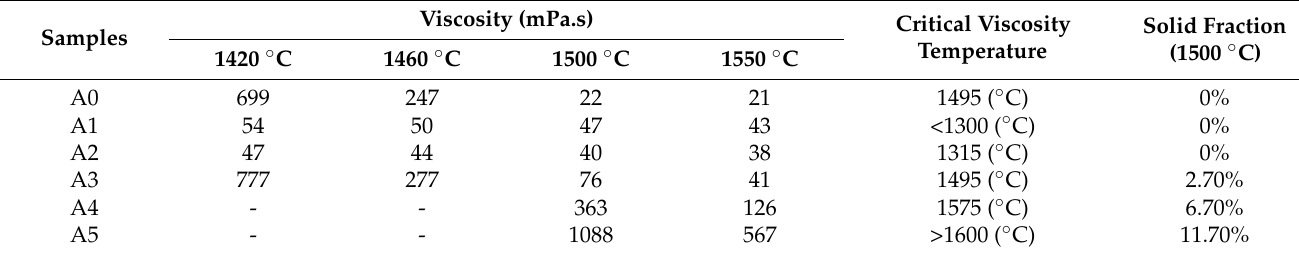
Table 2. Viscosities of A0–A5 at a specific temperature and the Tcv.